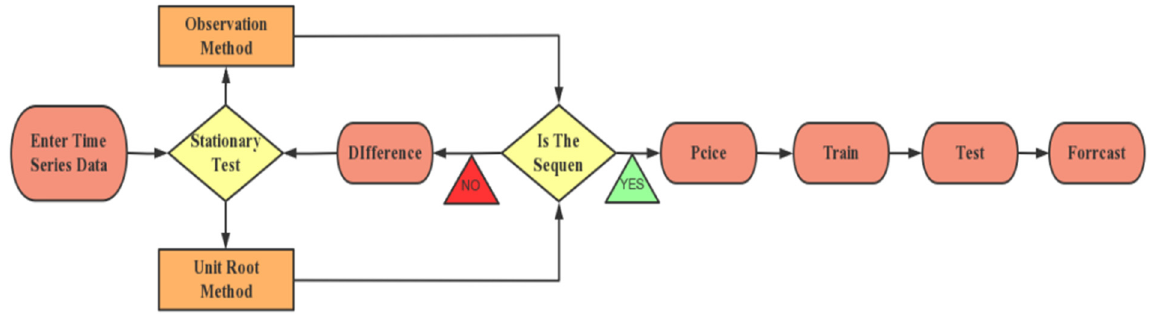
Figure 1: Design of a wireless M - bus communication system based on